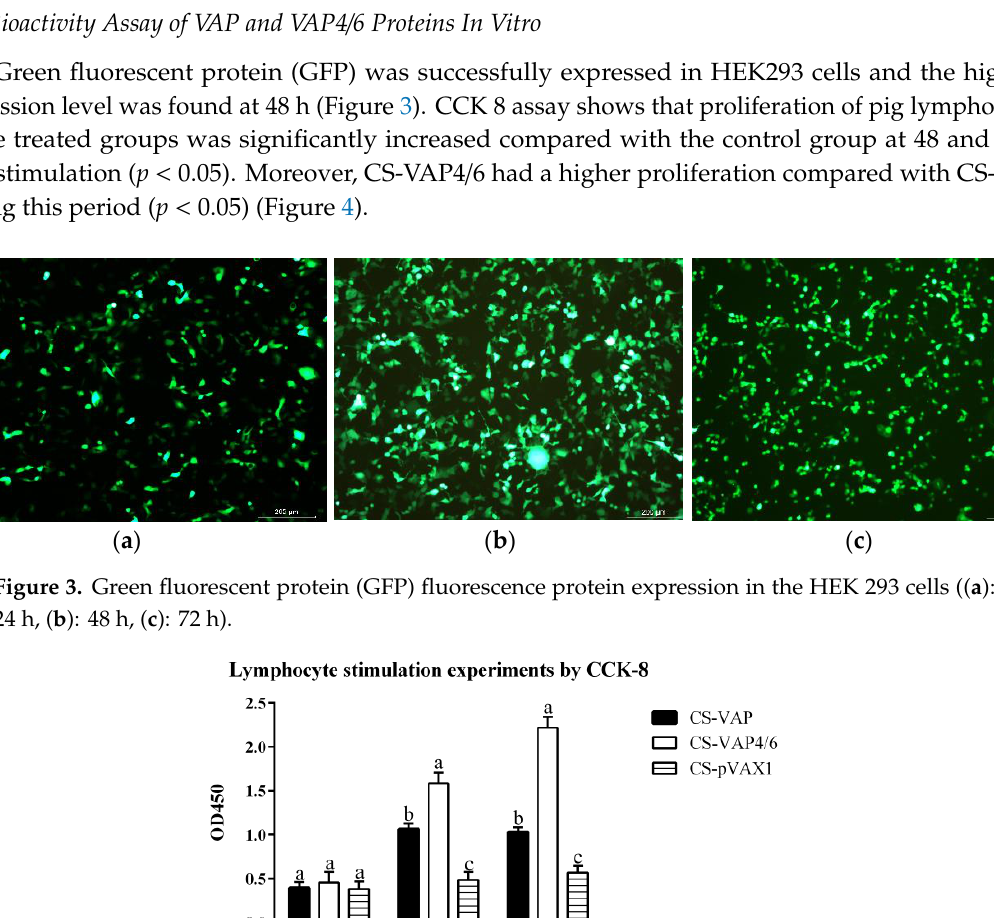
Figure 2. The parameters of average granule diameters and Zeta potentials of chitosan nanoparticles. ( a , c , e ) The average granule diameters of CS-VAP, CS-VAP4/6, and CS-pVAX1, respectively; Each color represents one test. ( b , d , f ) The Zeta potentials of CS-VAP, CS-VAP4/6, and CS-pVAX1, respectively.